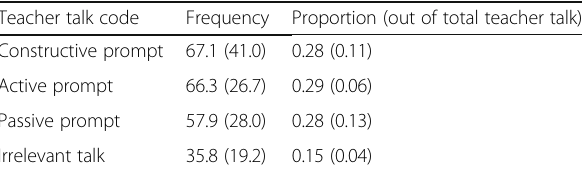
Table 3 Mean frequencies and proportions of teacher statements (with SD) Teacher talk code